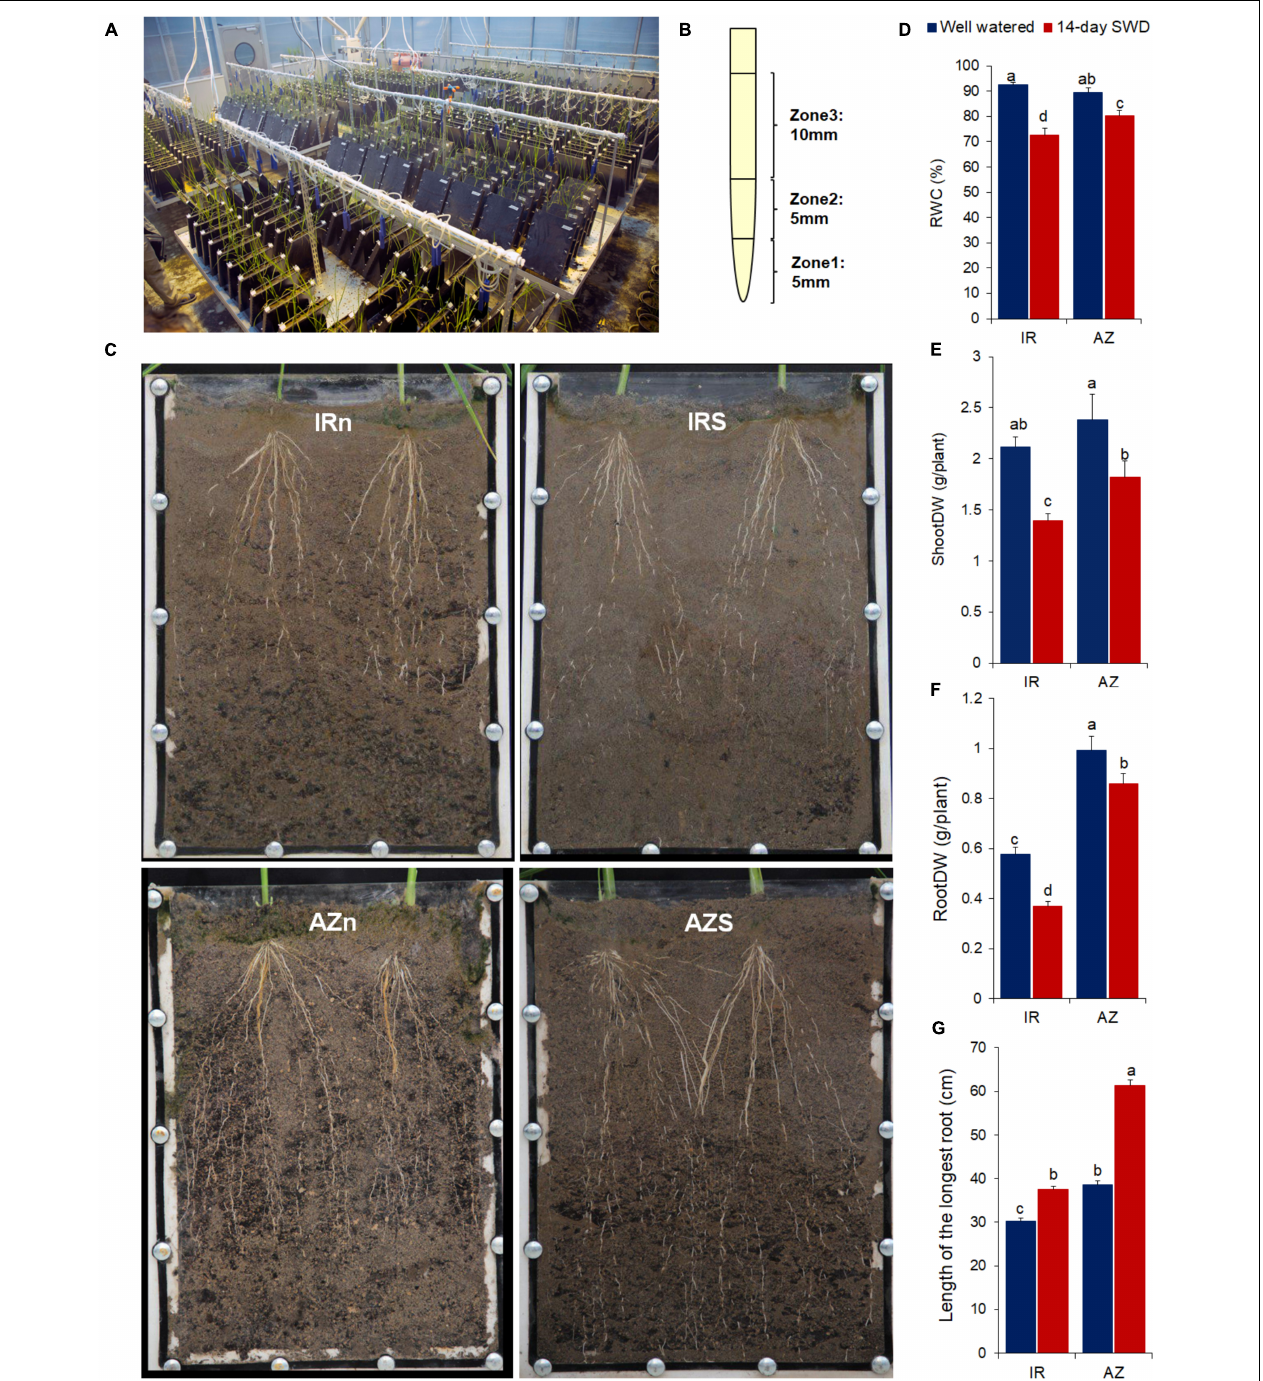
FIGURE 1 | Root sampling and phenotypic responses of two contrasting rice genotypes, Azucena and IR64, to water stress. (A) Soil-filled root boxes containing rice plants in the greenhouse; (B) root tip sampling; (C) the root length of IR64 (top panel, IRn and IRs) and Azucena (bottom panel, AZn and AZs) under well-watered (Left panel, IRn and AZn) and 14-day water withholding (right panel, IRs and AZs) conditions, shown in the transparent root boxes; 14-day-treated root boxes were watered prior to taking photos for a better resolution; (D) relative water content (RWC); (E) shoot dry weight; (F) root dry weight; and (G) length of the longest root of two contrasting genotypes of rice, IR64 (IR), the shallow rooting and sensitive genotype and Azucena (AZ), the deep rooting and tolerant genotype, grown in soil-filled root boxes in response to a 14-day water-deficit stress compared to well-watered samples. Values represent mean ± SE from six independent samples. The different letters indicate significant difference ( p ≤ 0.05) by Duncan’s test. (E) DW, dry weight; IRn, IR64 genotype under normal condition; IRs, IR64 genotype under water-deficit stress condition; AZn, Azucena genotype under normal condition; AZs, Azucena genotype under water-deficit stress